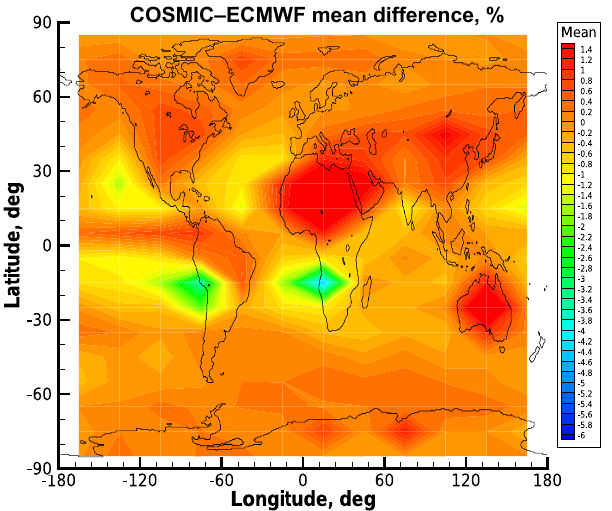
Figure 8. Deviation statistics based on original BLB-corrected bending angles: latitude–longitude map (10 ◦ lat × 30 ◦ long grid res- olution) of difference statistics of COSMIC observations relative to ECMWF profiles without fluctuations for refractivity at an altitude of 0.6km. Results are shown for COSMIC events and concurrent ECMWF analysis fields from the 1st, 11th, and 21st day of every month of year